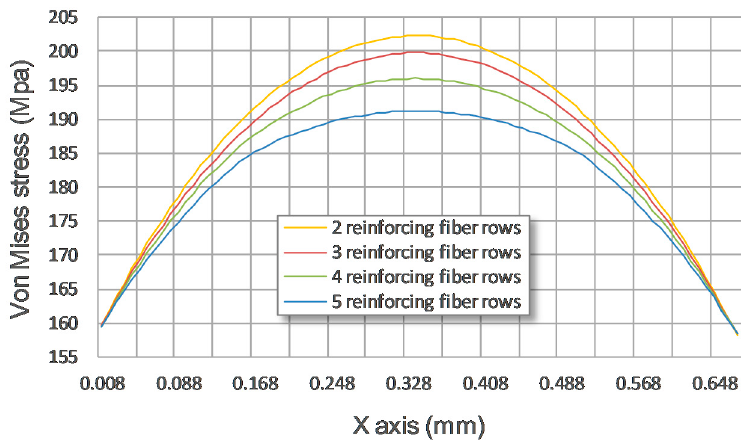
Figure 26. Stress distribution at line 2 for the four stress fields with different quantities of reinforcing fiber rows.